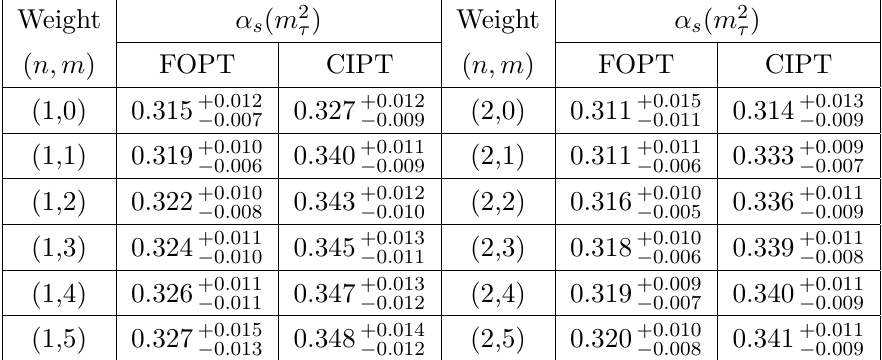
Table 2 . Values of the strong coupling extracted from a single A ω tions [40].